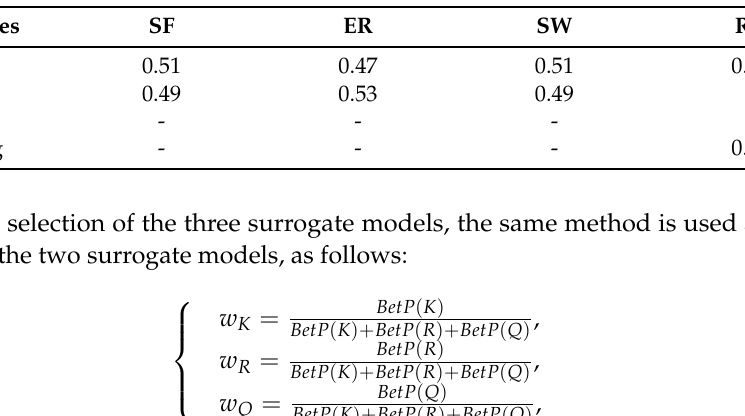
Table 3. Two mixture surrogate models.